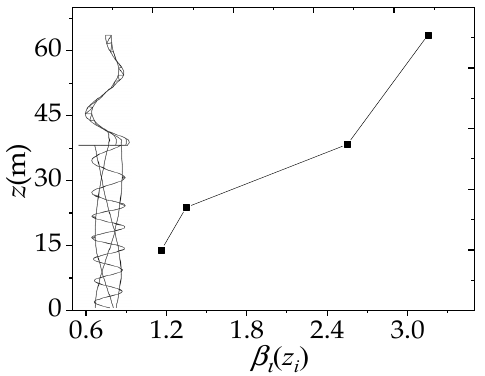
Figure 6. Test value of β i ( z